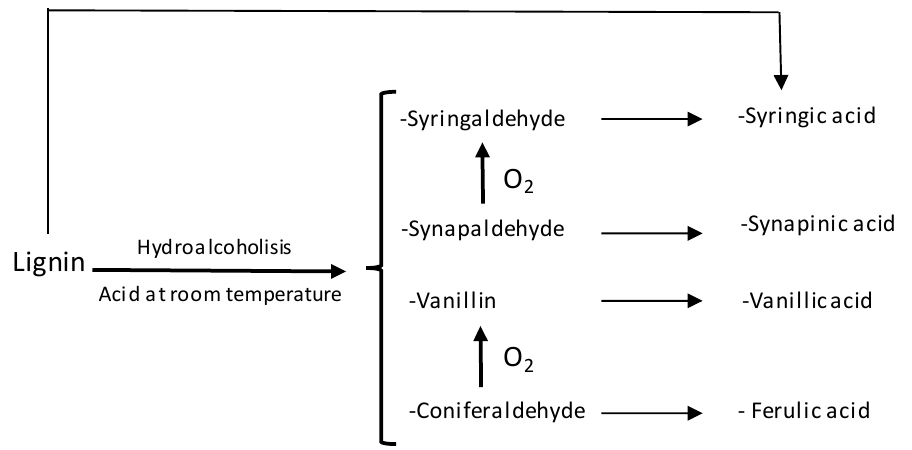
Figure 6. Formation and evolution of phenolic compounds from oak wood.